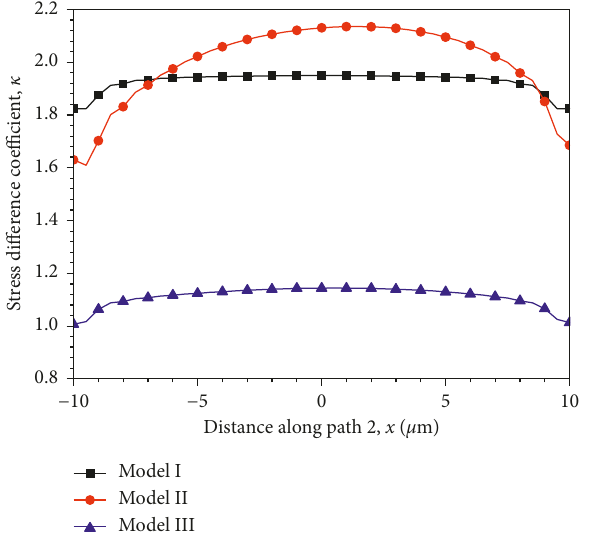
Figure 9: Mises stress concentration factor and Mises stress dif- ference coefficient of model I along path 2.